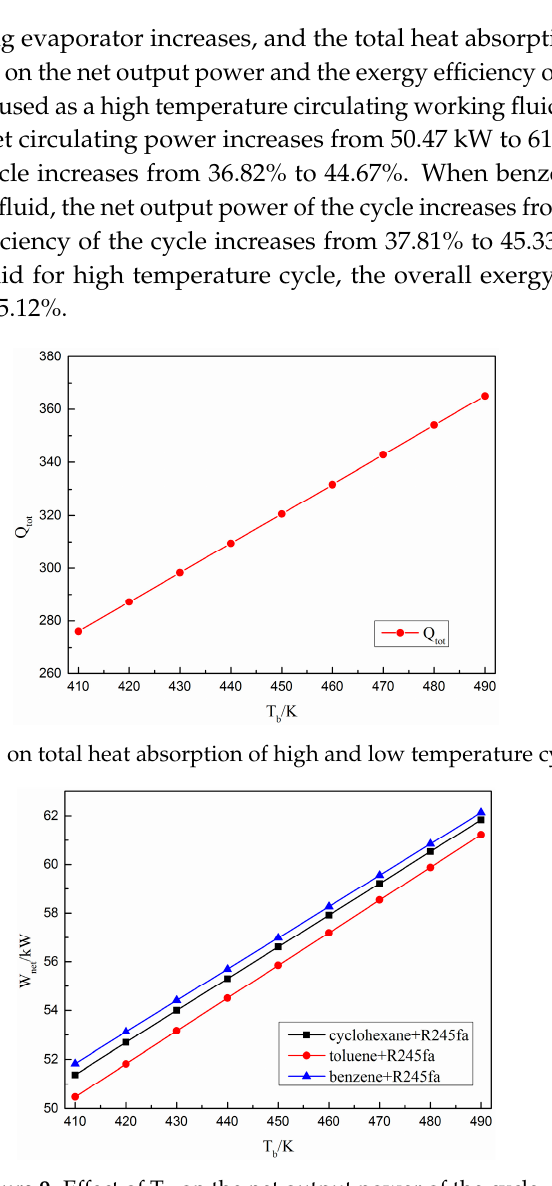
Figure 11. Effect of T b on cycle cooling load. 5. Conclusions In this paper, a two-stage organic Rankine cycle with a regenerator is designed to realize the cascade utilization of exhaust heat. The influence of regenerative heat on the thermal performance of the cycle was analyzed. At the same time, the influence of the primary heat exchange outlet temperature of exhaust gas on the thermal performance of the cycle was analyzed. The major conclusions are listed as follows: